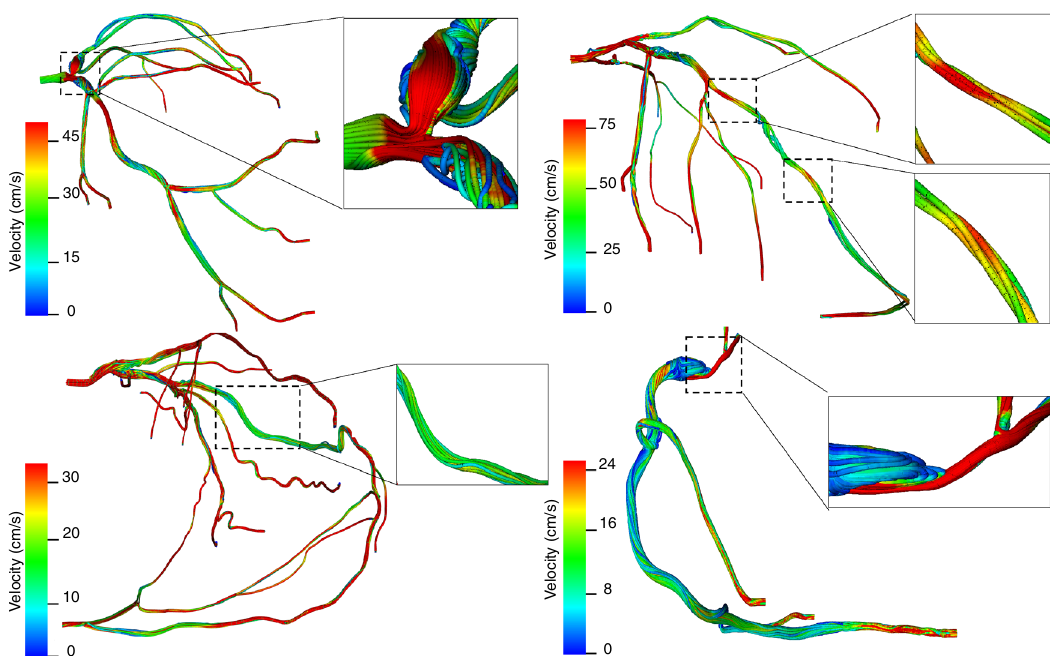
Figure 5. Velocity streamlines in arterial geometries with different complex coronary lesions: (top left) bifurcation lesion (top right) serial lesion (bottom left) RCA vascular bed via collaterals (bottom right) ostial lesions. The inset marks the region of the